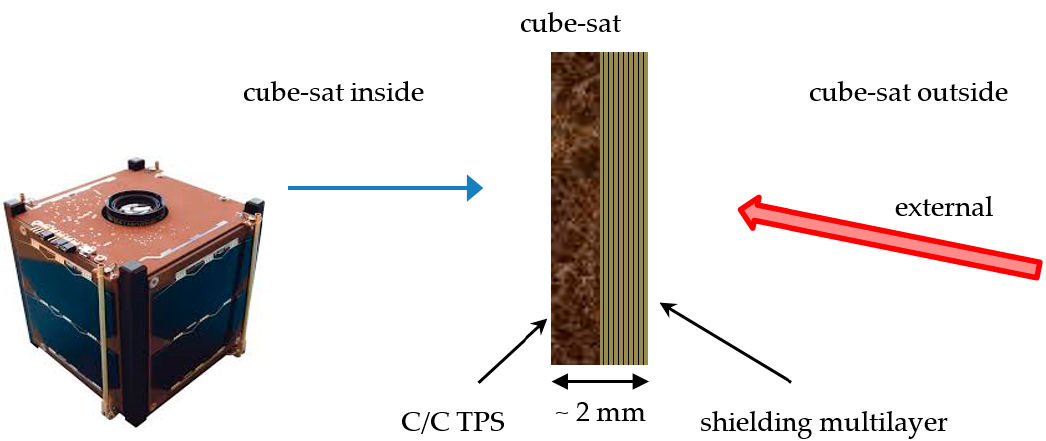
Figure 7. Sketch of the C/C multilayer hybrid structure in the stealth cube-sat configuration. TPS = thermal protection system.